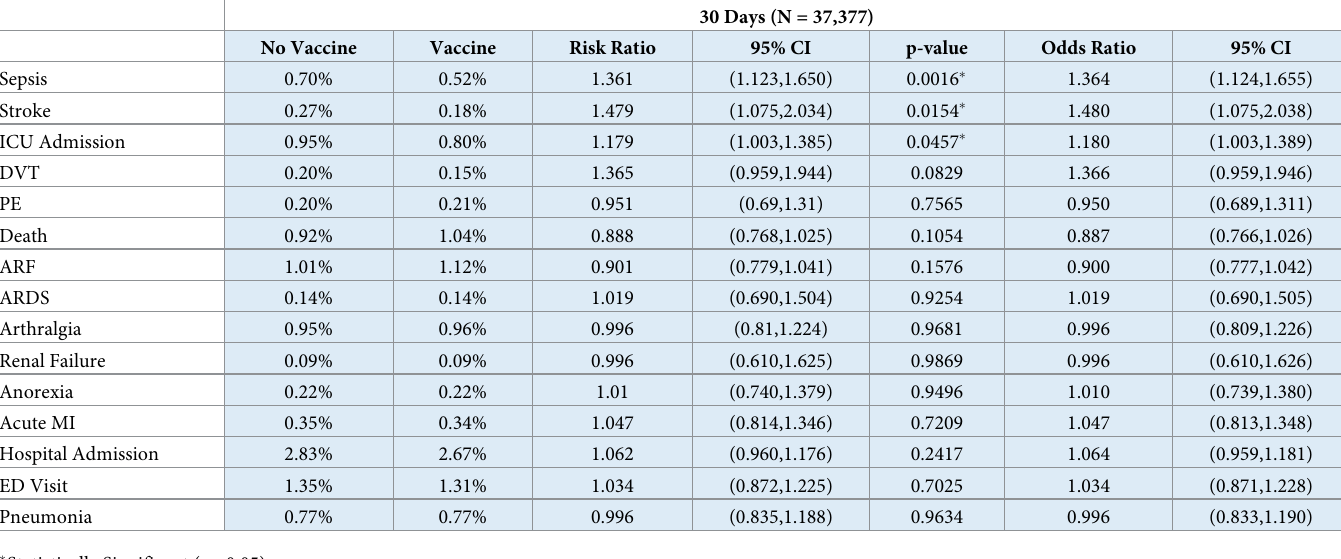
Table 2. Statistical analysis of adverse outcomes within 30 days of SARS-CoV-2-positive diagnosis.